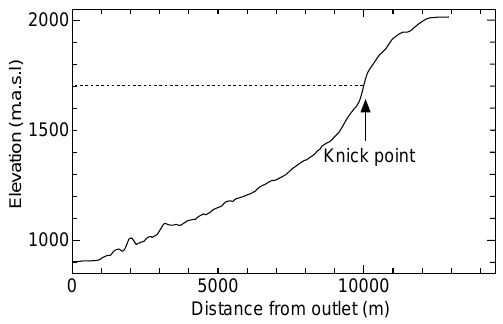
Figure 19. Longitudinal profile of the longest stream in SNK. Knick point is identified as the point at which the stream slope is the steep-